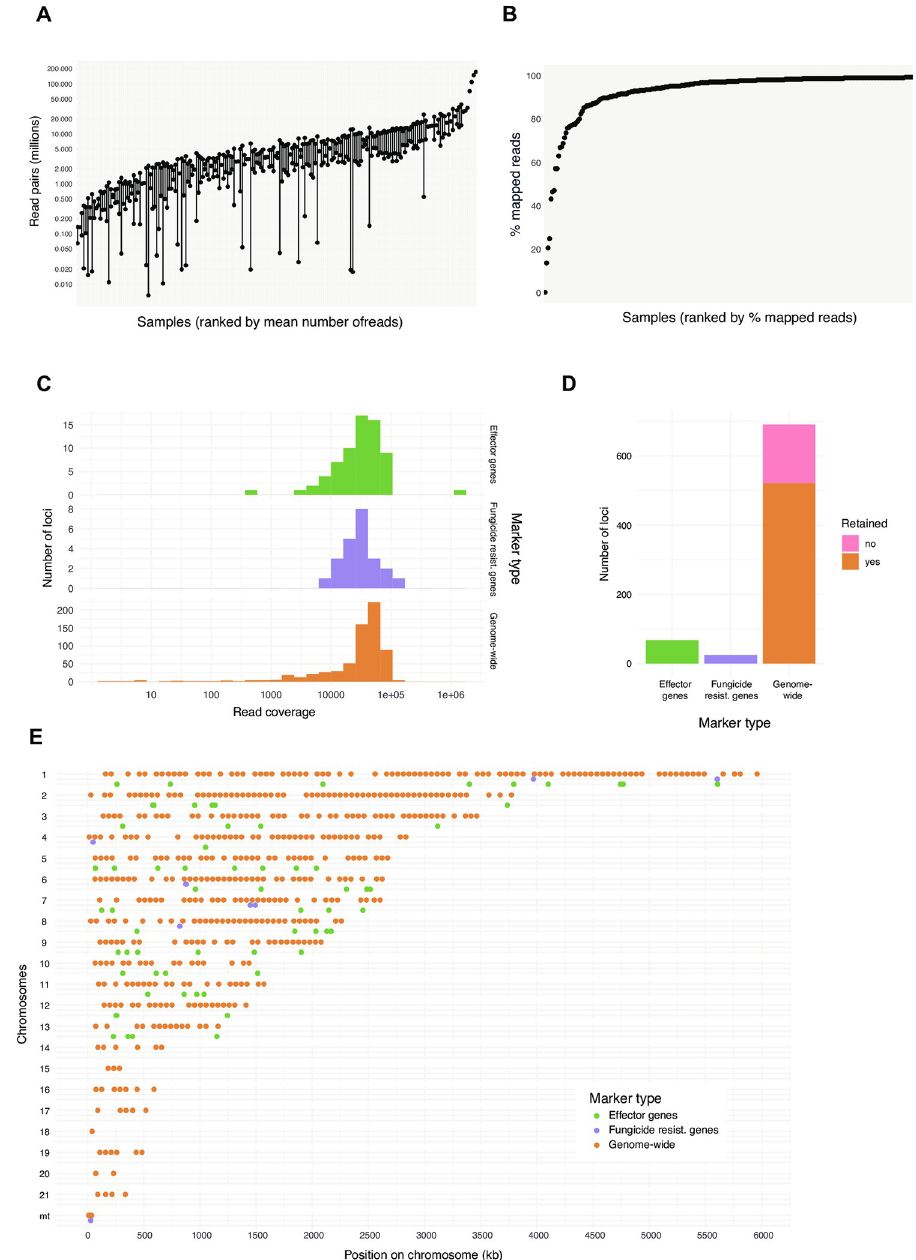
Fig 2. Sequencing data recovered for the amplicon assay and loci assessment. A) Read pairs recovered per sample and replicate. Each sample was amplified and sequenced two times (two different microfluidic flow cells). B) Ranking of percent mapped reads to the reference genome per sample (including both replicates if available). C) Number of reads mapped per locus for the three different categories of markers. The read numbers correspond to the total obtained from four pooled samples performed in replicates. D) Summary of loci retained after read number filtering. Only genome-wide markers were removed if they failed filtering criteria. E) Overview of retained markers per category across the 21 chromosomes and